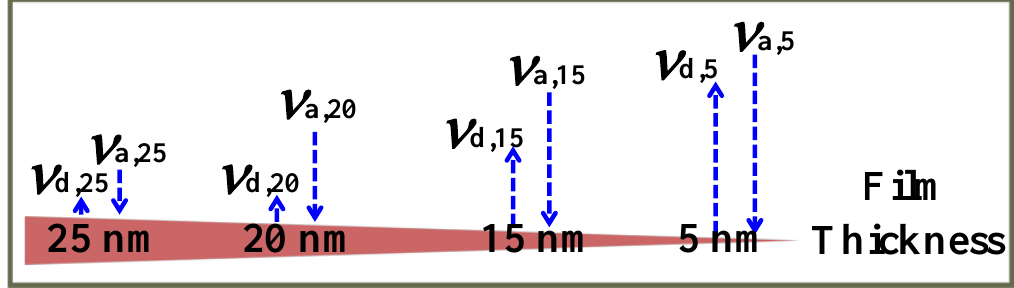
Figure 5. The supposed sensing process of H 2 S in film of polymer PSFDTBT. Both adsorption and desorption speeds of H 2 S molecules increase when the polymer films become thinner. However, desorption speed ( ν d,n ; n = 25, 20, 15, and 5 nm) increases much faster than adsorption speed ( ν a,n ). The length of arrows denotes the level of the speed.